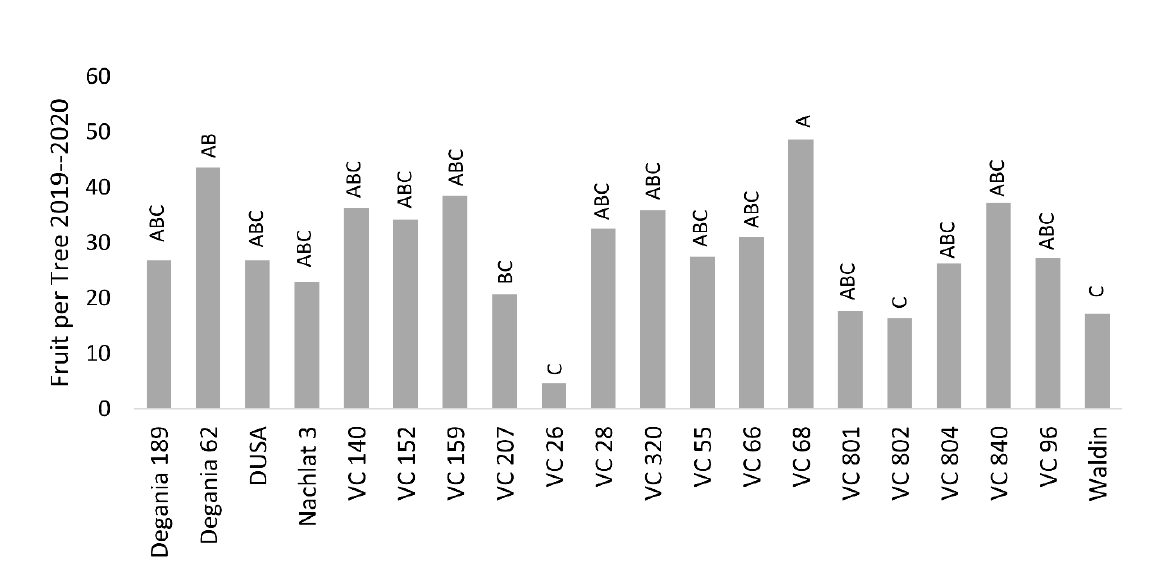
Figure 8. Biannual yield (average number of fruit per tree) of ‘Hass’ avocado trees grafted onto various rootstocks, under salinity exposure. Different letters represent significant ( p ≤ 0.05) differences between rootstocks. SD values are presented in Table S1.